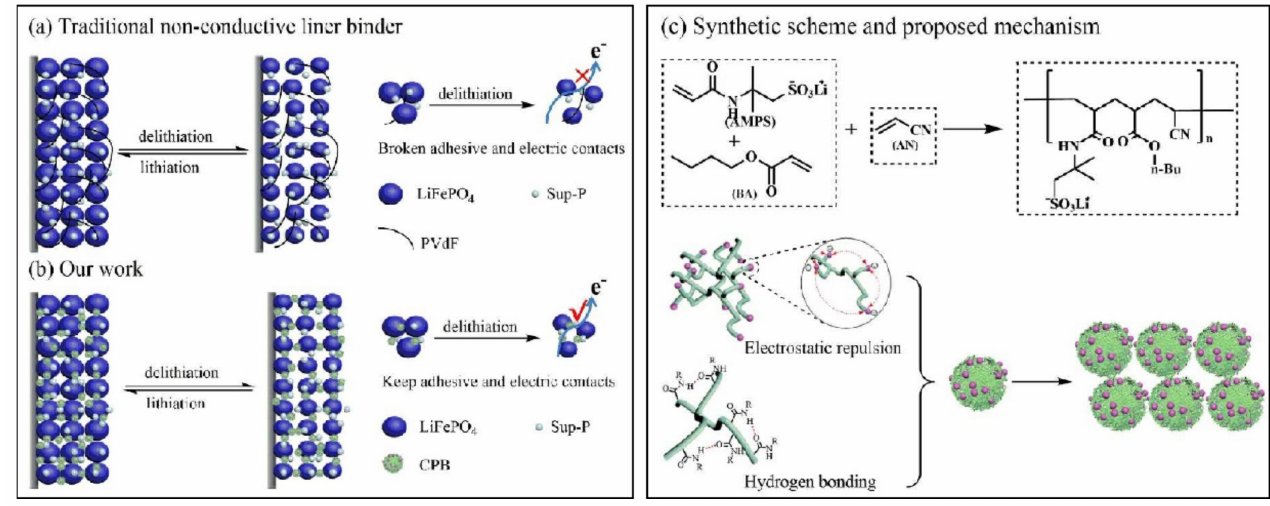
Figure 6. Schematics of the approaches to addressing electrode integrity issues in battery materials. ( a ) Traditional ap- proaches using PVDF as a non-conductive polymer binder. ( b ) Replacing one-dimensional binders or two-dimensional binders, a 3D conductive binder could maintain the electrical and mechanical integrity of the electrode during charge/discharge cycles. ( c ) Schematic illustration of the synthesis and proposed mechanism of the conductive poly- mer binder (CPB) in this study. Reprinted with permission from ref. [79]. Copyright 2018